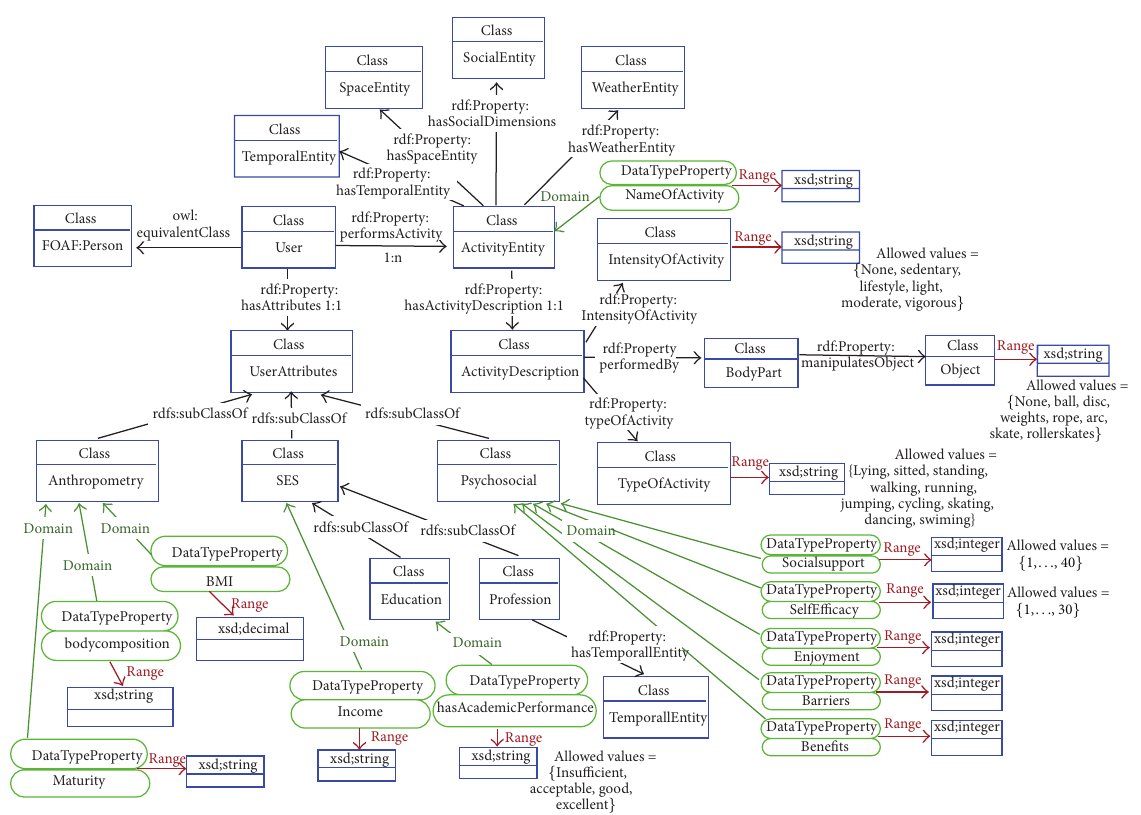
Figure 3: Conceptual diagram to characterize an individual performing physical